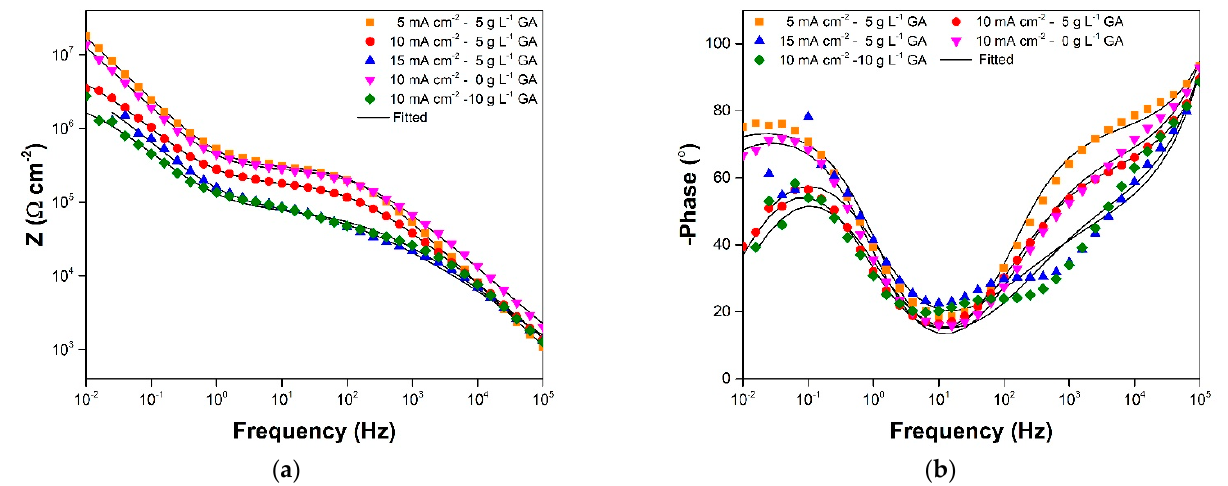
Figure 3. ( a ) Bode-modulus and ( b ) Bode-phase plots at 0-day immersion in 3.5 wt.% NaCl maintained in ambient conditions.